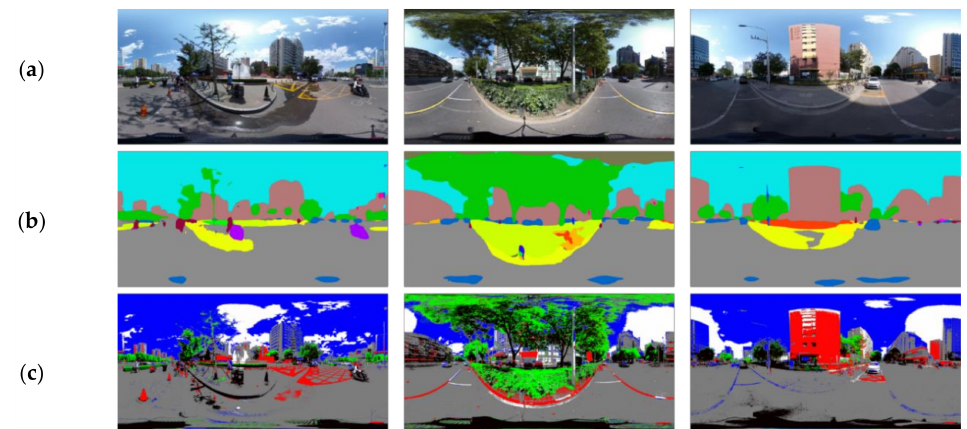
Figure 2. Examples of the street scene semantic segmentation and color classification results: ( a ) original images; ( b ) semantic segmentation results; ( c ) color classification results.